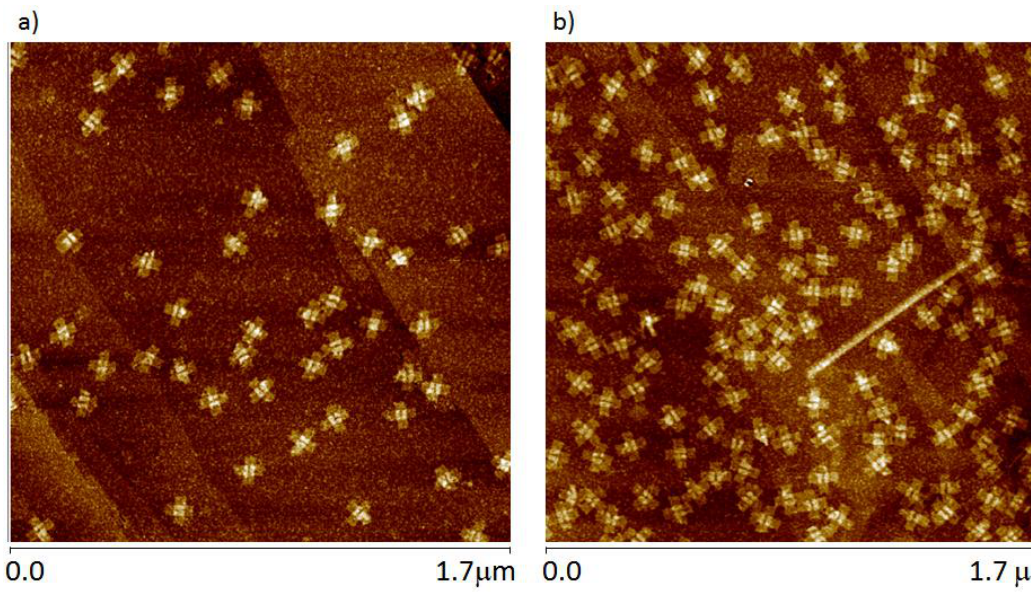
Figure 2. AFM images of the cDO (with long ssDNA segments) ( a ) and cDO E (with short 5-base ssDNA extensions) ( b ) on highly oriented pyrolytic graphite (HOPG).